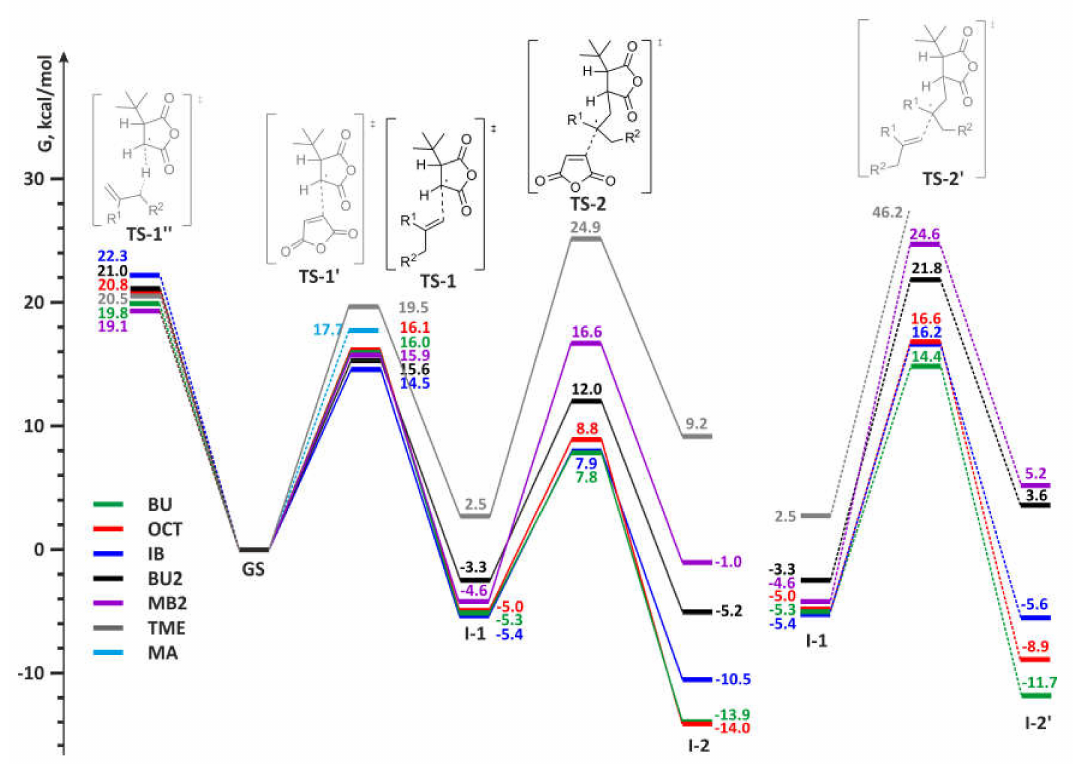
Figure 7. Free energy profiles for main (left) and side (right) reactions during radical copolymerization of MA and